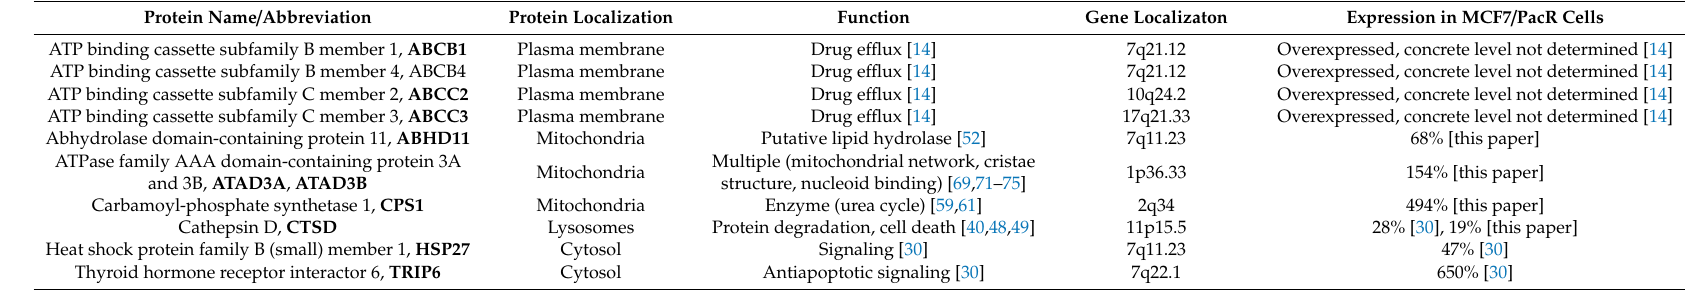
Table 2. All identified protein expression change in paclitaxel-resistant MCF7 / PacR cells compared to paclitaxel-sensitive MCF7 cells. The table includes protein name, protein localization within the cell, known or predicted function in the cell, localization of the gene within the human genome, expression level in MCF7 / PacR cells (compared to the level in MCF7 cells) determined by western blot, and corresponding